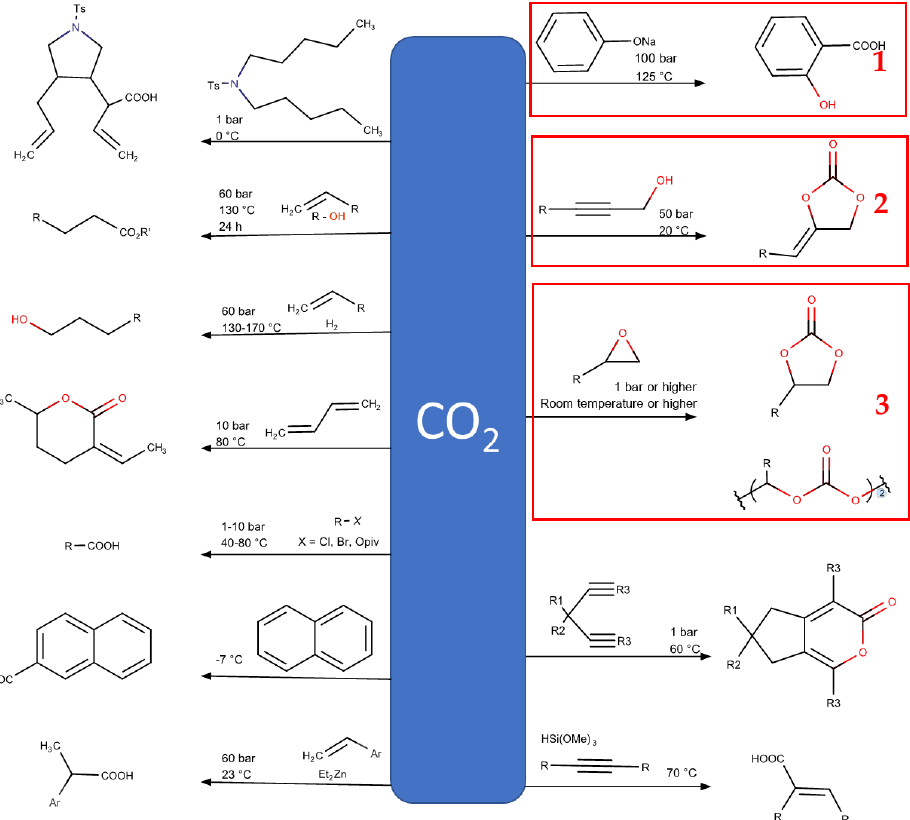
Figure 2. Examples of CO 2 as C1 feedstock in organic synthesis. The synthesis reactions marked with red boxes have been industrialized [7–9] .